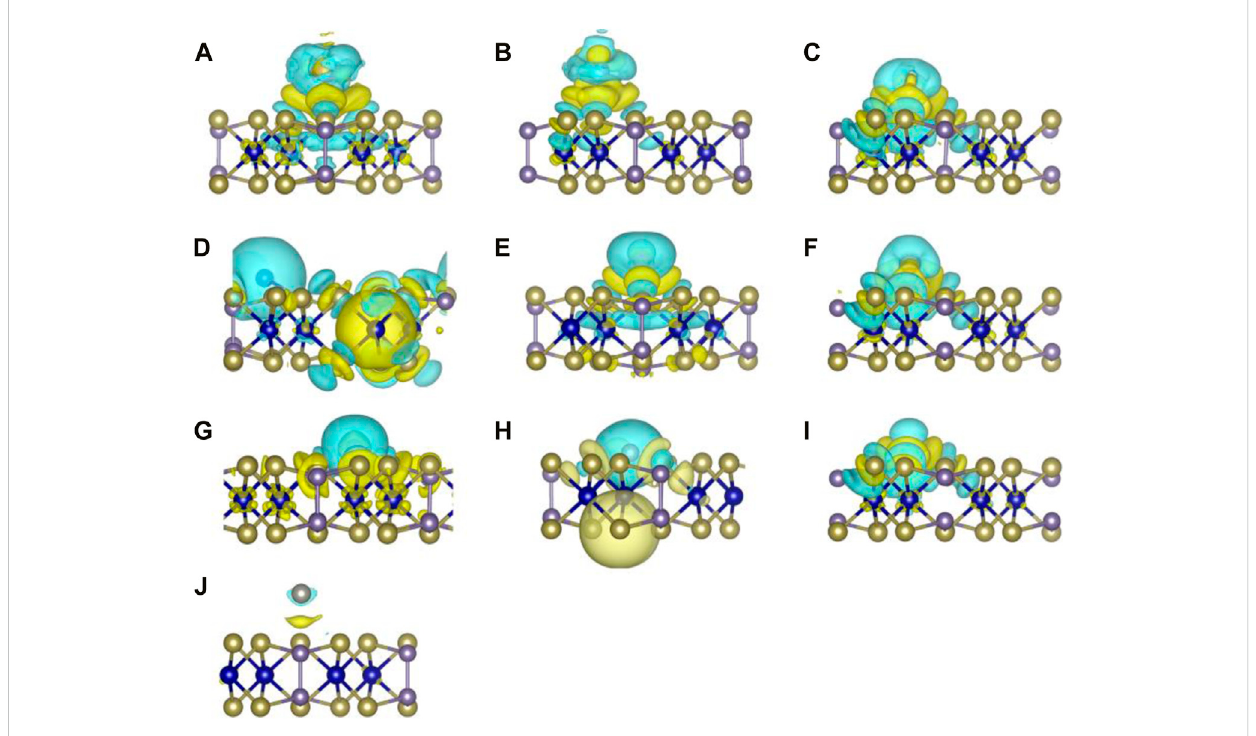
FIGURE 4 The differential charge density of (A) Cr 2 G 2 Te 6 @Sc, (B) Cr 2 G 2 Te 6 @Ti, (C) Cr 2 G 2 Te 6 @V, (D) Cr 2 G 2 Te 6 @Cr, (E) Cr 2 G 2 Te 6 @Mn, (F) Cr 2 G 2 Te 6 @Fe, (G)